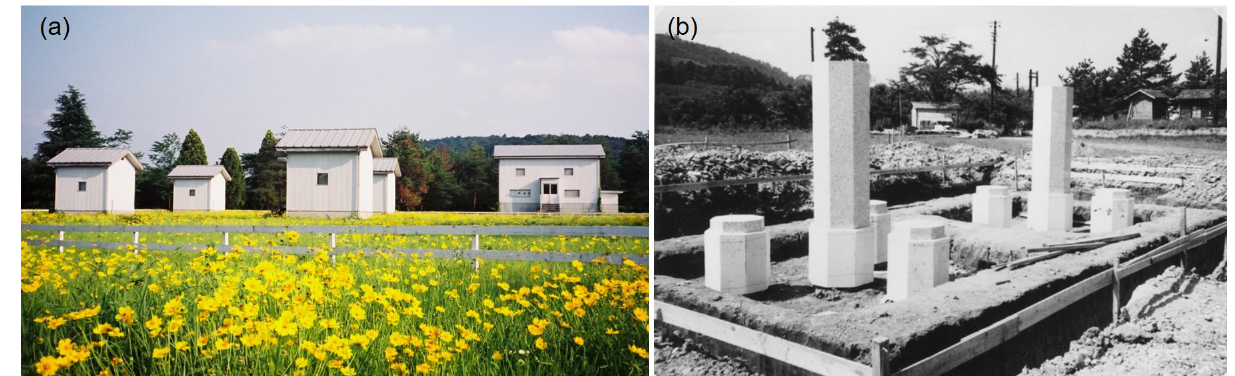
Figure 27. Huts where KASMMER instruments are installed. (a) The biggest hut is for DI-72, and four small huts are for optical pumping magnetometers. (b) Two 3.6m pillars for theodolites were installed in the process of constructing the biggest hut ( a : photo taken by Ikuko Fujii and b : photo supplied by Kakioka Magnetic